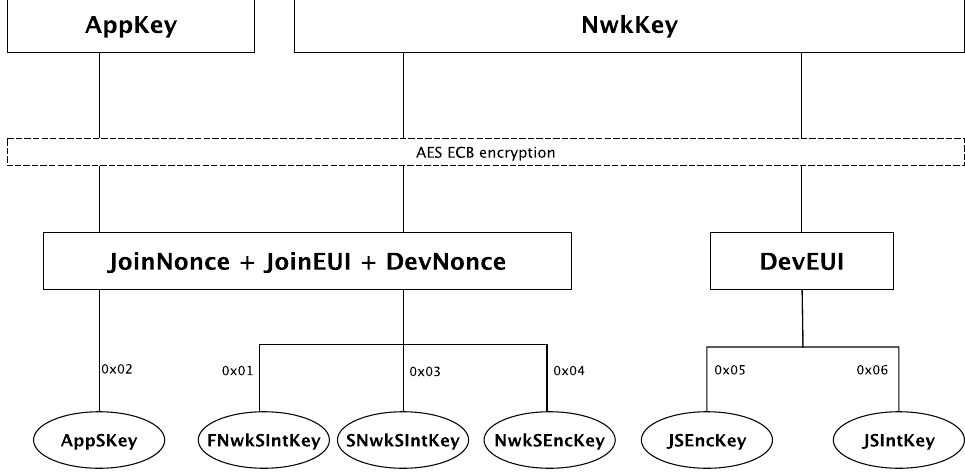
Figure 1. LoRaWAN 1.1 Key Derivation scheme